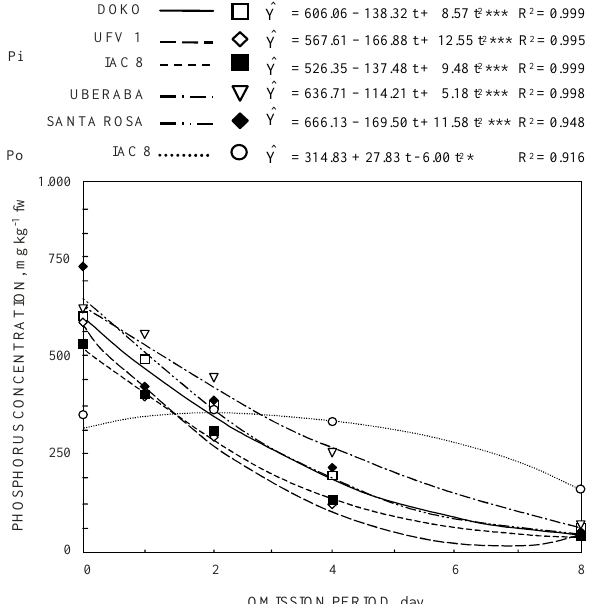
Figure 4. Inorganic P (Pi) and organic P (Po) concentration in root fresh matter of five soybean cultivars as a function of the P omission period. (*, ***: Significant at 10 and 1 %,